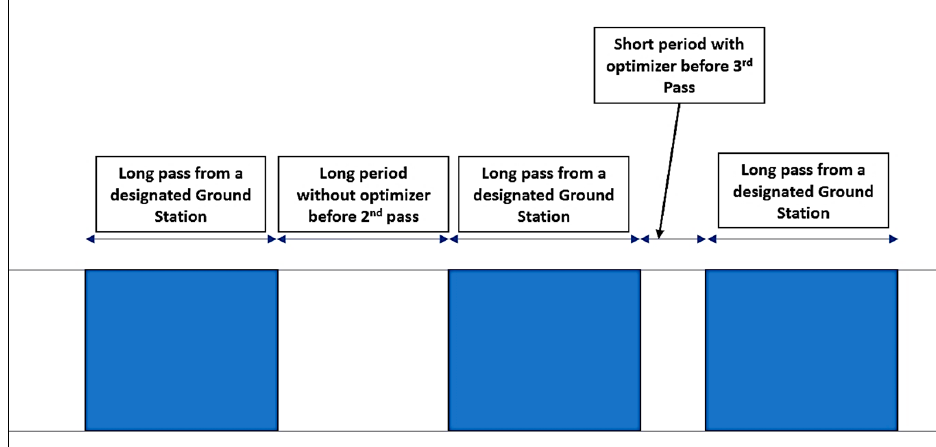
Figure 3. Effect of using an efficient optimization technique .